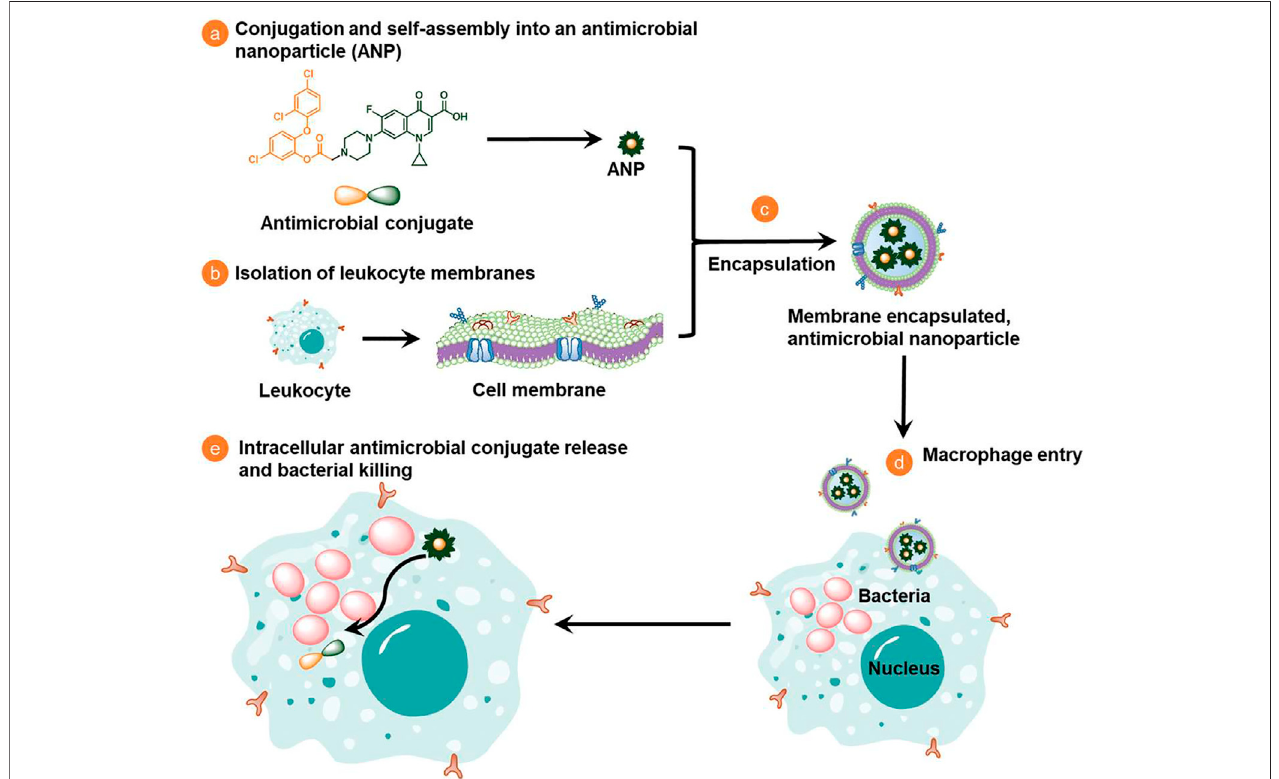
FIGURE 1 | Schematic illustration on the design, synthesis, and potential mechanism of macrophage-monocyte membrane-encapsulated, antimicrobial- conjugated nanoparticles to kill intracellular bacteria (Li et al., 2020).